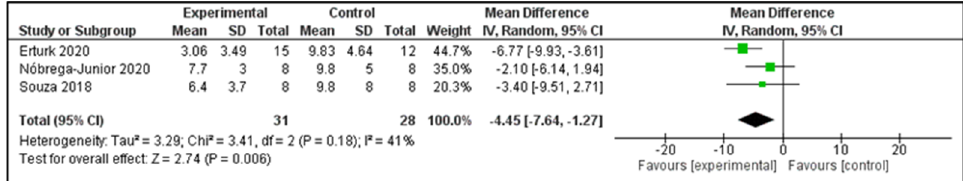
Figure 5. Forest plot for Epworth sleepiness scale.